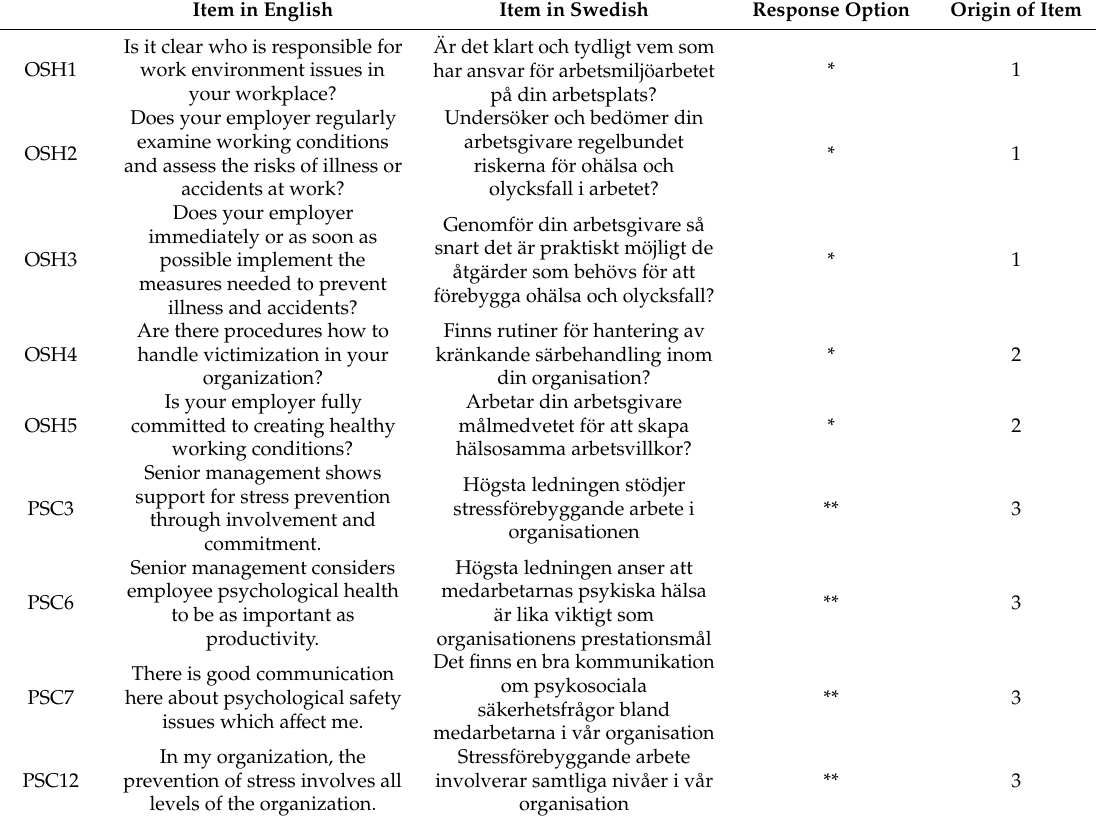
Table A1. Item formulations in English and Swedish for Occupational Safety and Health (OSH) practices and PSC